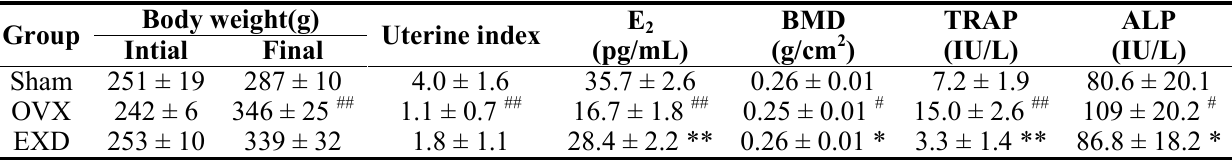
Table 1. Osteoporosis-related indexes in control, OVX and Er-Xian Decoction (EXD) treatment group.